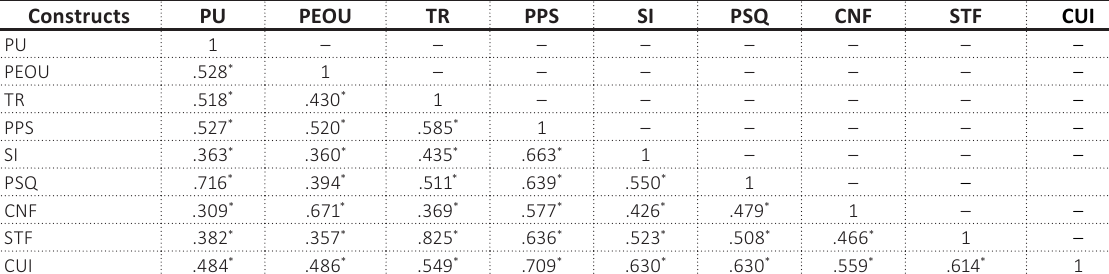
Table 2. Correlation among study variables